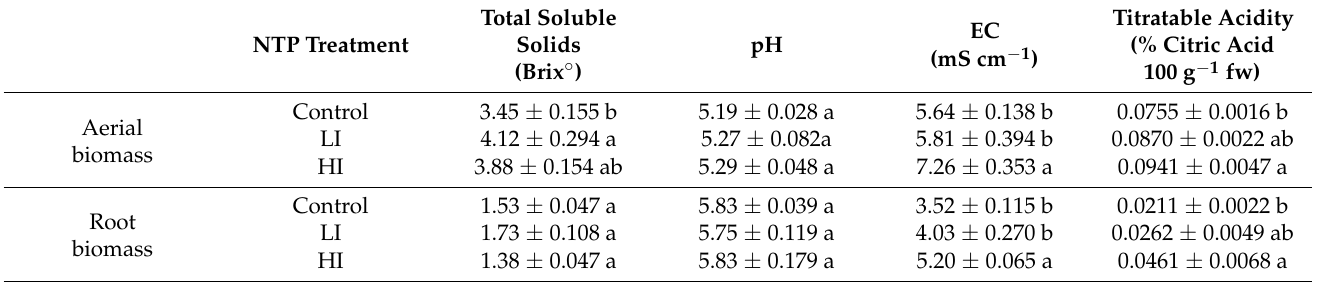
Within each qualitative trait, values with different letters are significantly different at p < 0.05 based on the Tukey test (HSD). LI= low ionization intensity; HI= high ionization intensity; fw = fresh weight. Each value comes from three replications, and the standard error is